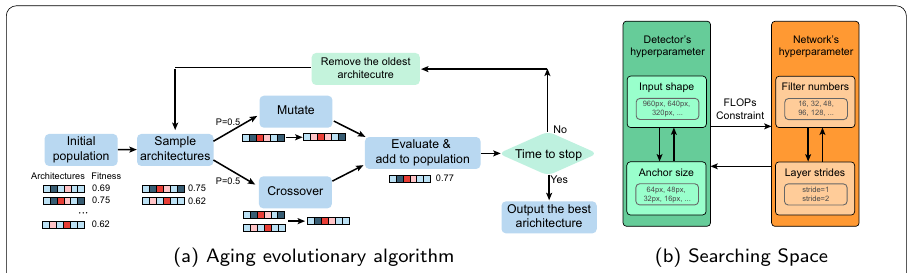
Fig. 1 The framework of the aging evolutionary algorithm and the proposed searching space. Each colored vector is a group of hyperparameters, which makes up a